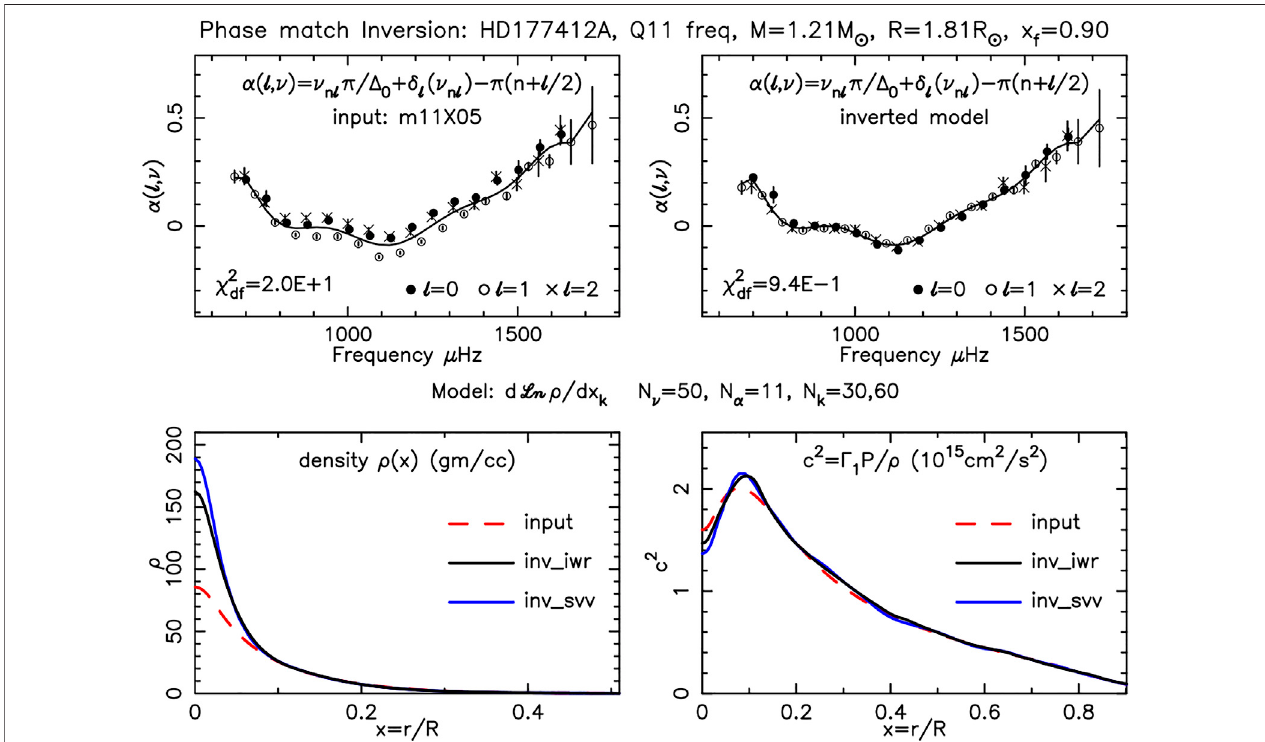
FIGURE 11 | Upper panels : Agreement in outer phase shift for the input “ LM ” model (left) and the inverted model (right). Lower panels : Density (left) and squared adiabatic sound speed pro fi les (right) for inversion result (black) and input model (red) for the so-called “ LM ” model.